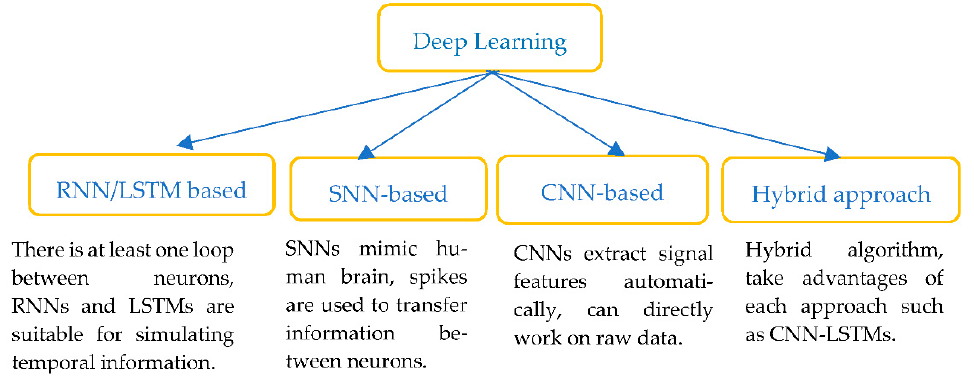
Figure 6. Classification of Deep learning methods.